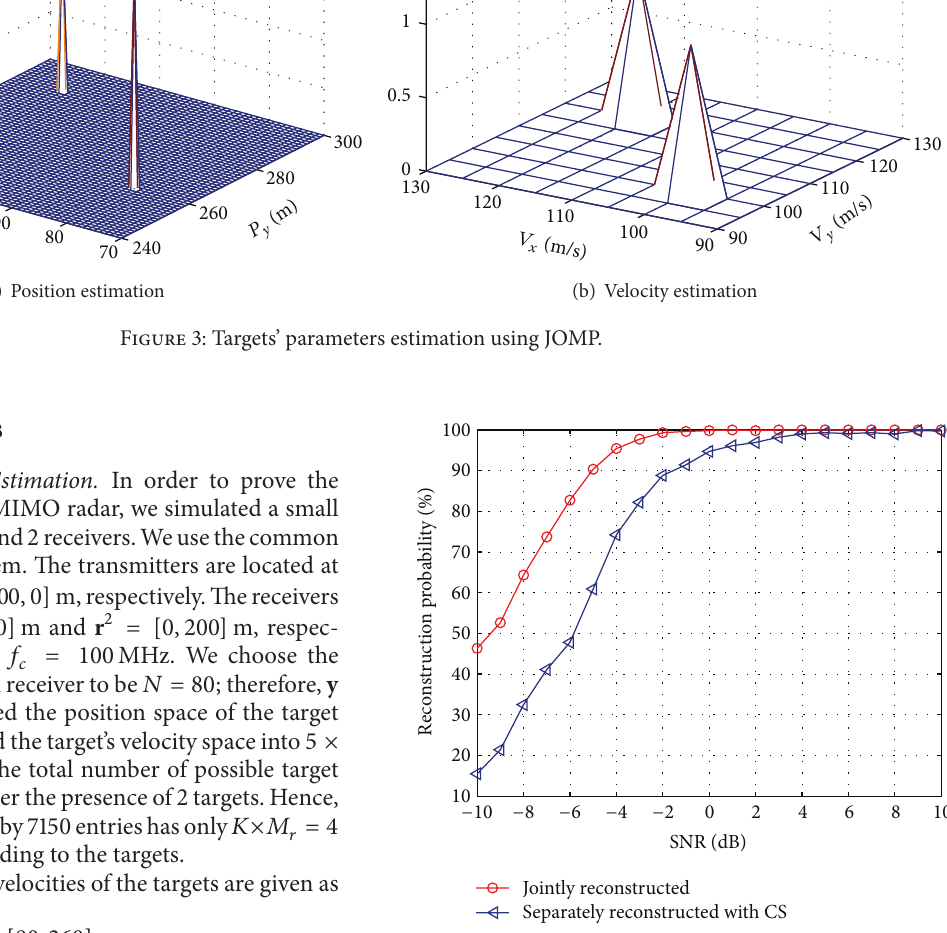
Figure 4: Reconstruction probability for the system using joint sparse modeling and the system using CS in each receiver separately as a function of